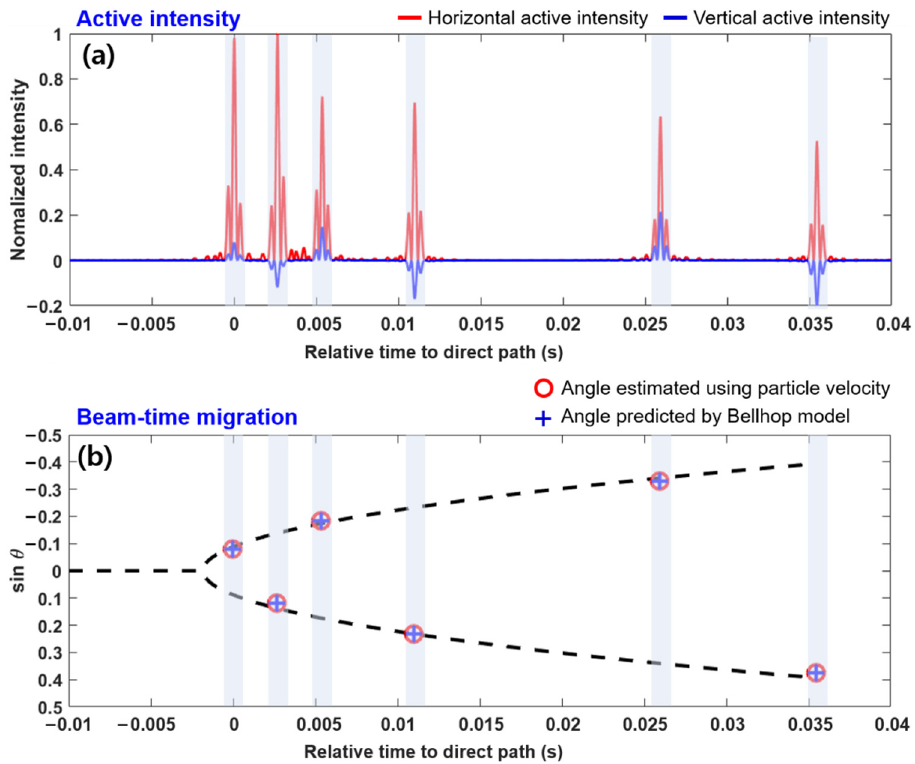
Figure 2. ( a ) Six eigenrays: direct (D), bottom (B), sea surface (S), surface–bottom (S–B), bottom– surface (B–S), and bottom–surface–bottom (B–S–B) paths, in this order, based on ( b ) the water sound speed profile. ( c ) Matched–filtered outputs of acoustic pressure and horizontal and vertical components of particle velocity scaled by acoustic impedance  𝑐 , where ρ is water density and 𝑐 is water sound speed.